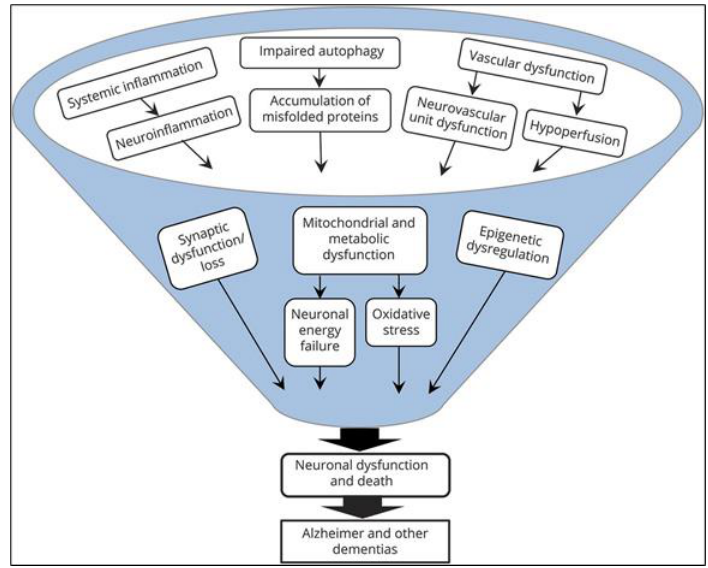
Figure 1. Microglial cells respond differently depending upon type and intensity of activation signals [17].